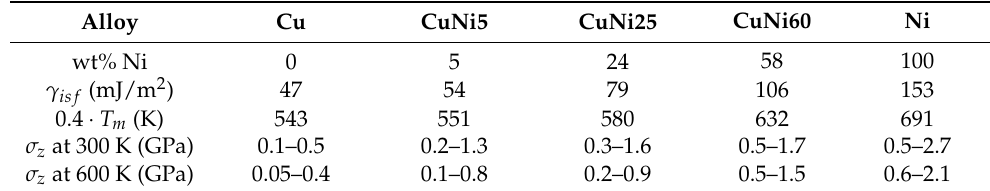
Table 1. Considered alloys (named according to their atomic Ni content), Ni content by weight, intrinsic stacking fault energy γ isf (taken and interpolated from [37]), 0.4 times the melting tempera- ture T m , and the normal pressure σ z ranges applied in our simulations. Alloy Cu CuNi5 CuNi25 CuNi60 Ni wt% Ni 0 100 γ isf (mJ/m 2